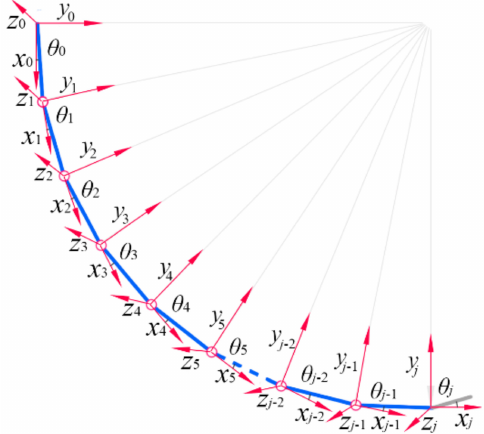
Figure 5. Simplification of the pneumatic module of the proposed SPA.